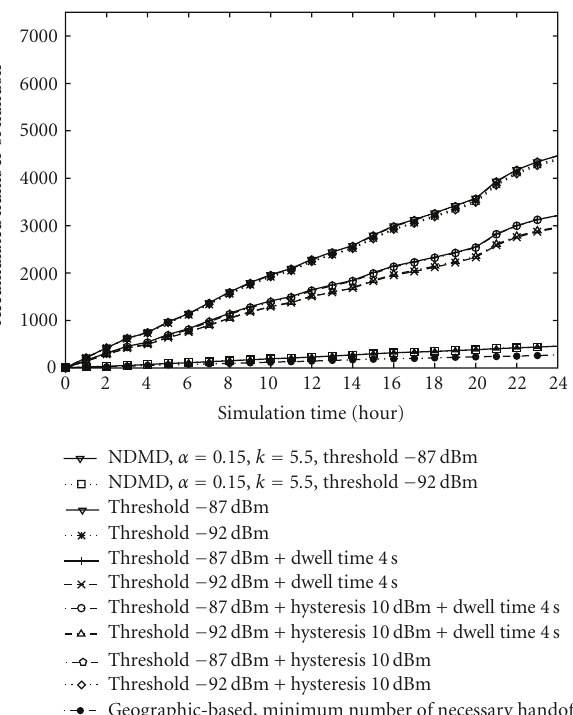
Figure 23: Accumulated number of hando ff in